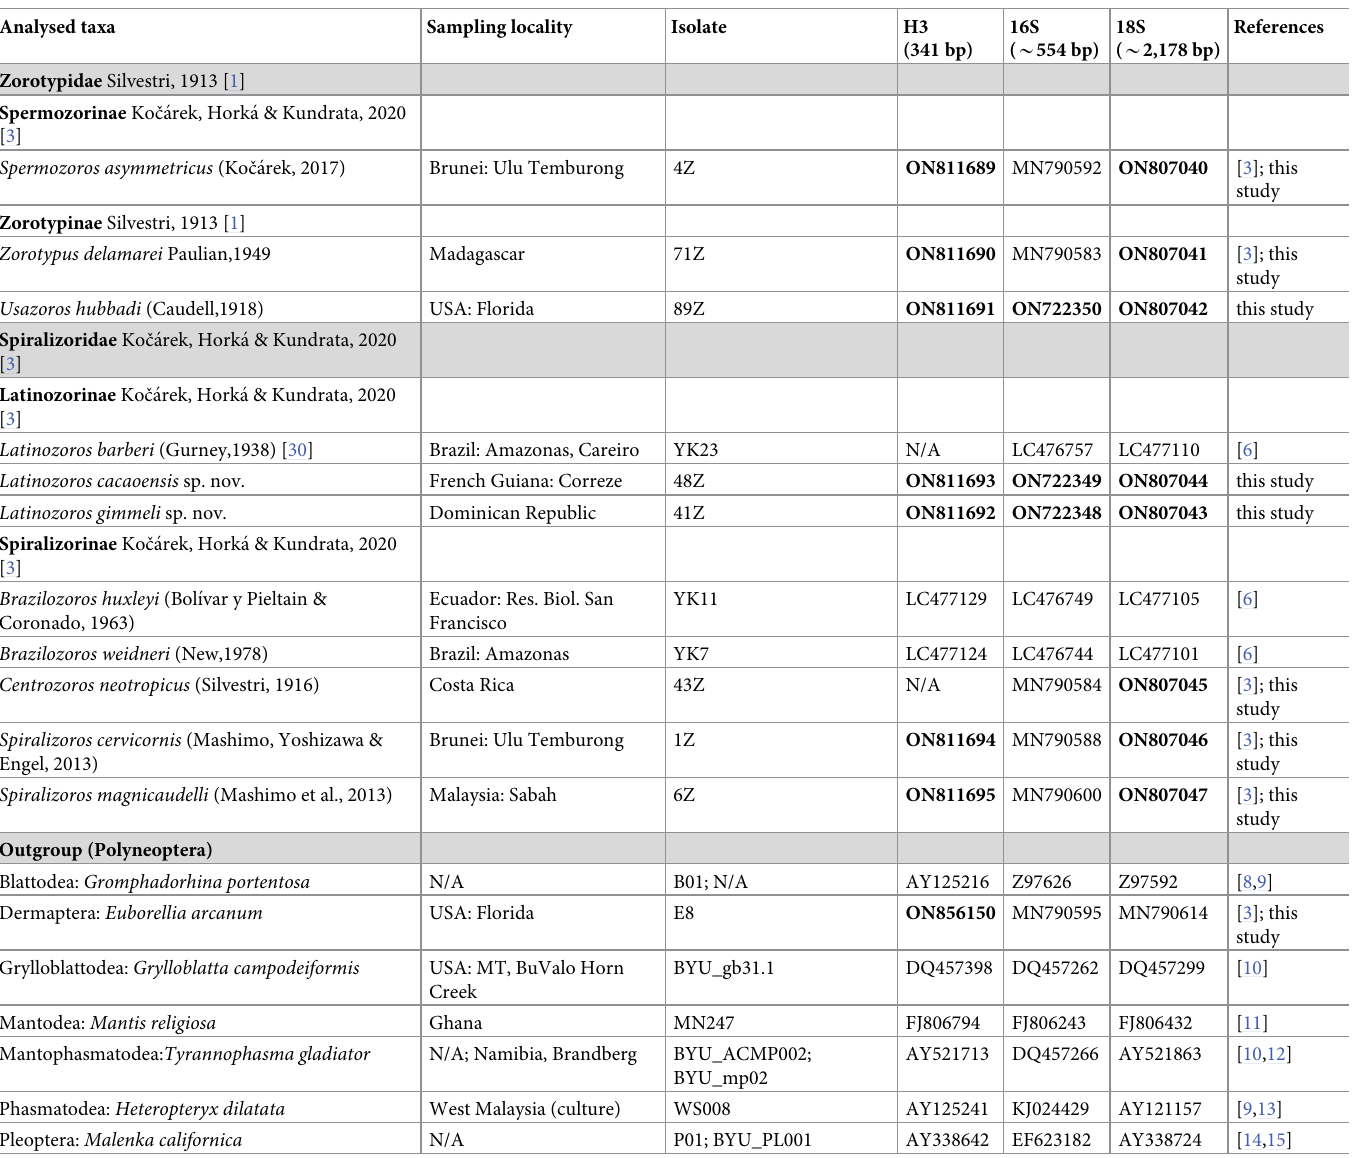
Table 1. Details of the material used in the phylogenetic analyses. Newly obtained sequences are marked in bold. N/A–not available. For species in quotation marks, see Materials and Methods. Analysed